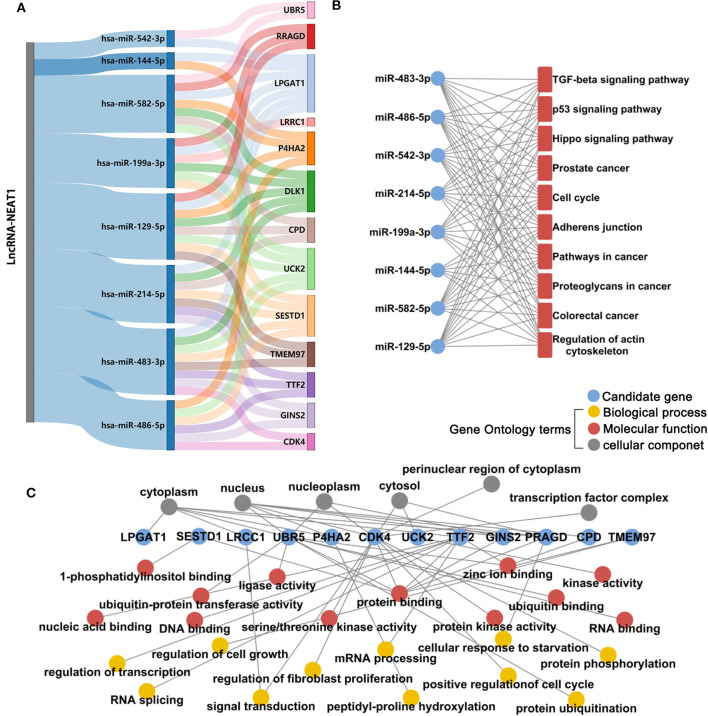
Microarray and integrative bioinformatics analysis of HCC-associated miRNA-mRNA pairs that are potentially regulated by lncRNA-NEAT1. (A) Differentially expressed miRNAs and mRNAs in lnc-NEAT1 knock-down SNU-182cells were identified by microarray analysis. According to the ceRNA theory, miRNAs that may be sponged by lncRNA-NEAT1 and their possible target mRNAs were also predicted by bioinformatics analysis and filtered according to their expression patterns in 7 public HCC-related datasets. Candidate miRNA-mRNA pairs that passed each of these filters are shown in the Sankey diagram. The miRNAs that are shown are predicted to act as suppressors in HCC. (B) KEGG pathway enrichment analysis for the 8 candidate microRNA's target genes. (C) GO enrichment analysis for the 13 candidate genes. GO-biological process terms, -molecular function terms and -cellular component terms are shown.